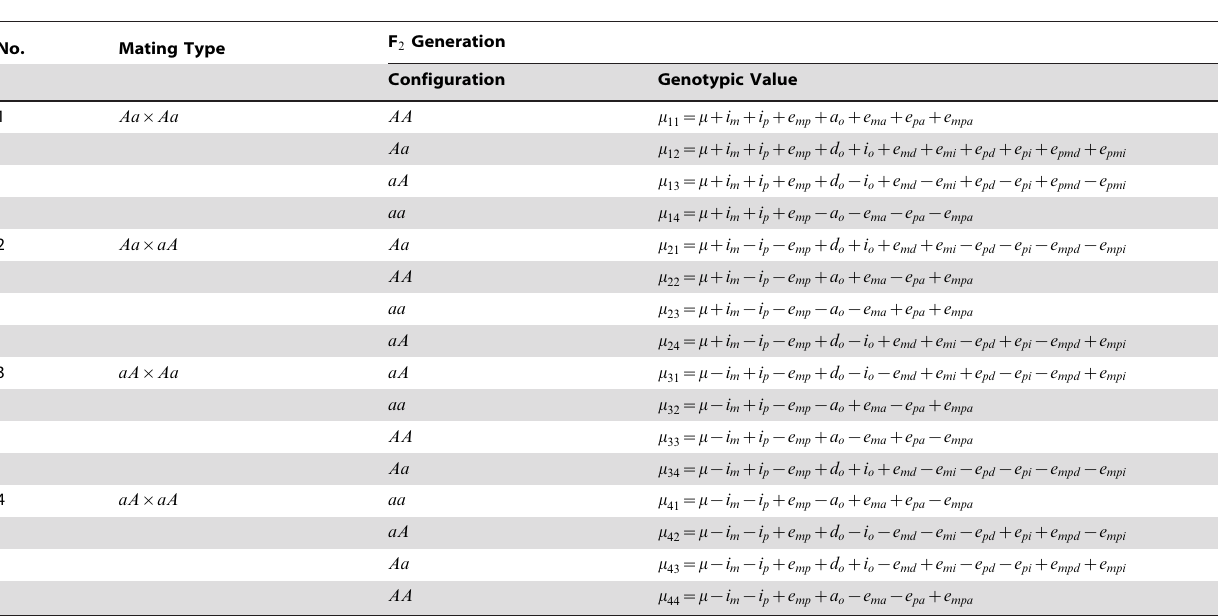
Table 1. Genetic components of 16 F 2 configurations derived from two successive reciprocal crosses.